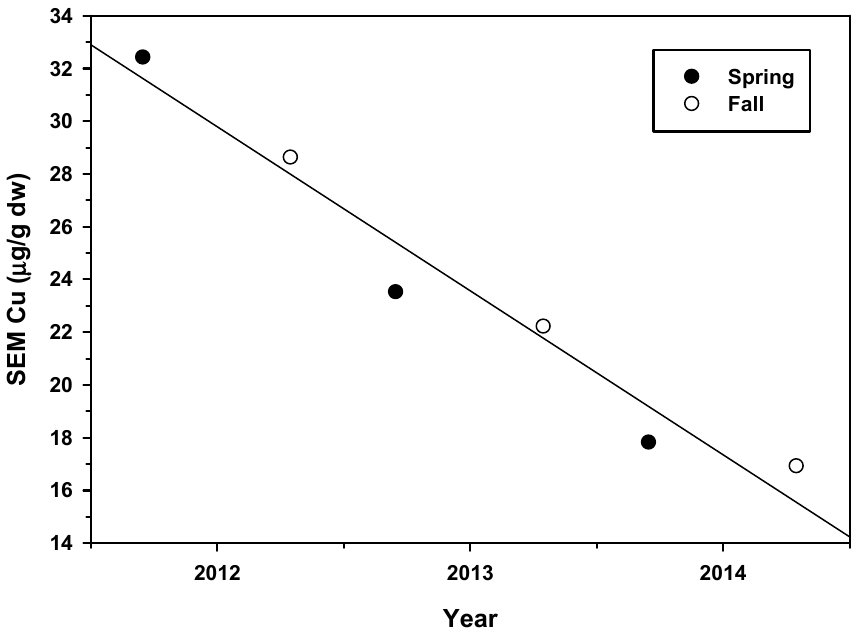
Figure 14. Regression results of sediment SEM copper concentrations (µg/g dry wt) from spring and fall sediment sampling at Cache Slough site CS-04 for the years 2012, 2013 and 2014. (r 2 = 0.953, p < 0.001).